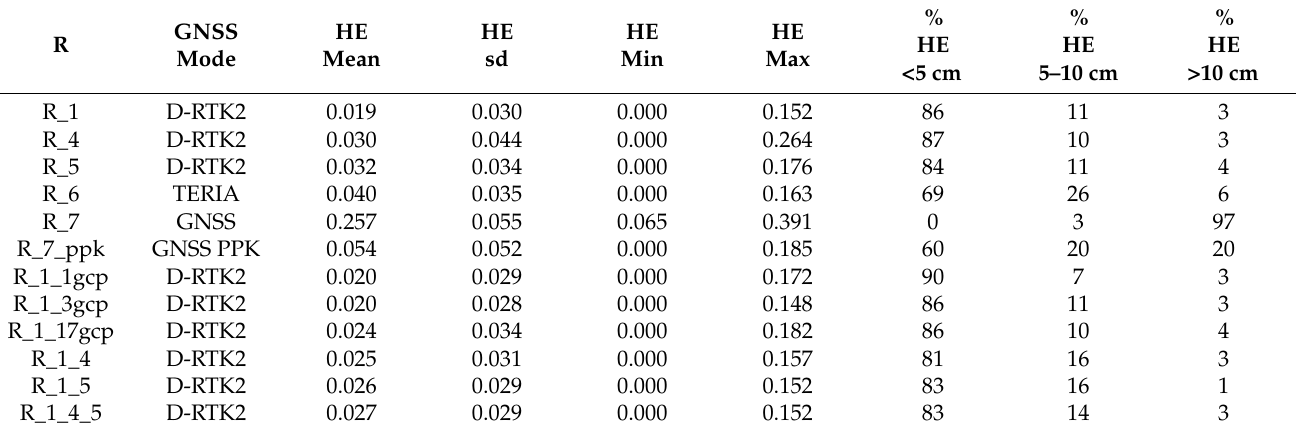
Table 9. Horizontal error (HE) statistics on maize plant position for the 12 reconstructions. The per- centages represent the percentage of the maize plant population for which the horizontal error is in a distance interval.